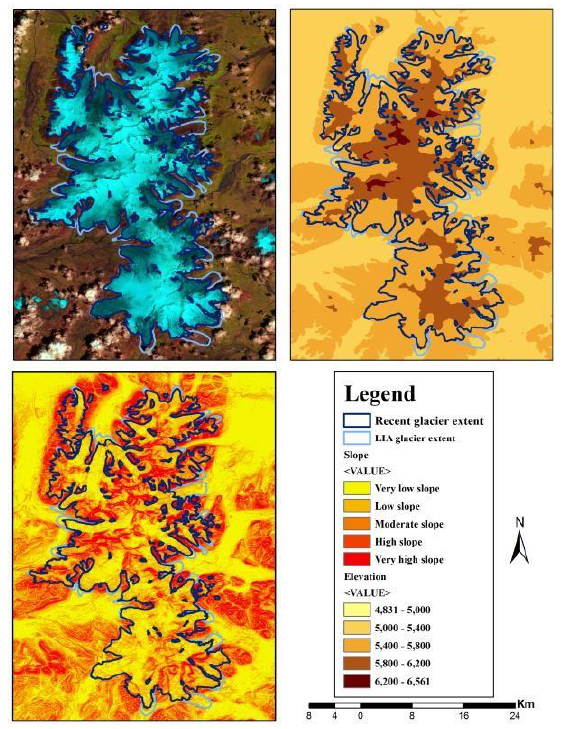
Figure 2. Recent and LIA maximum glacier extent of the Geladandong main